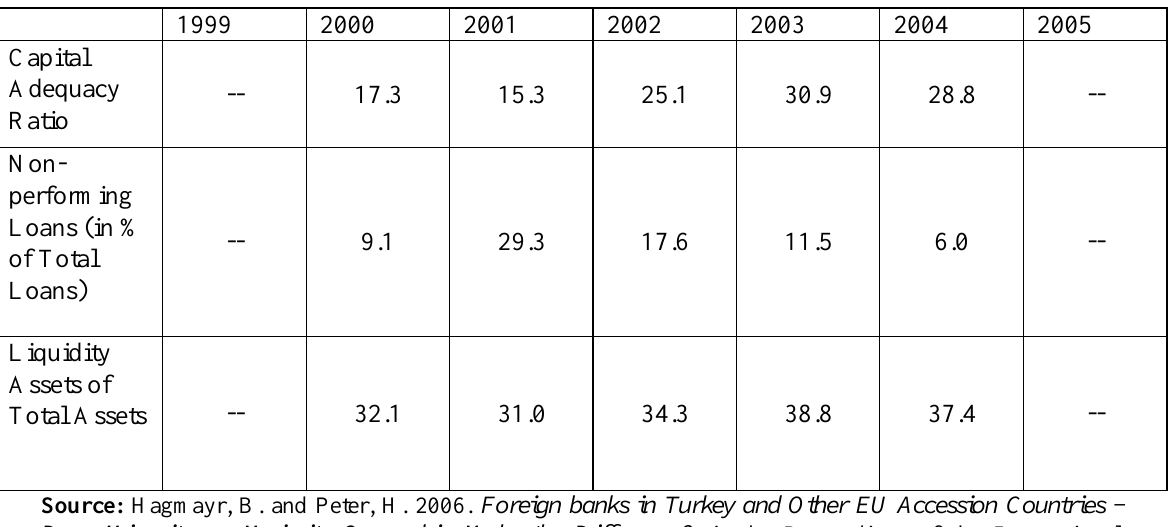
Table 2a. Prudential Banking Sector Indicators